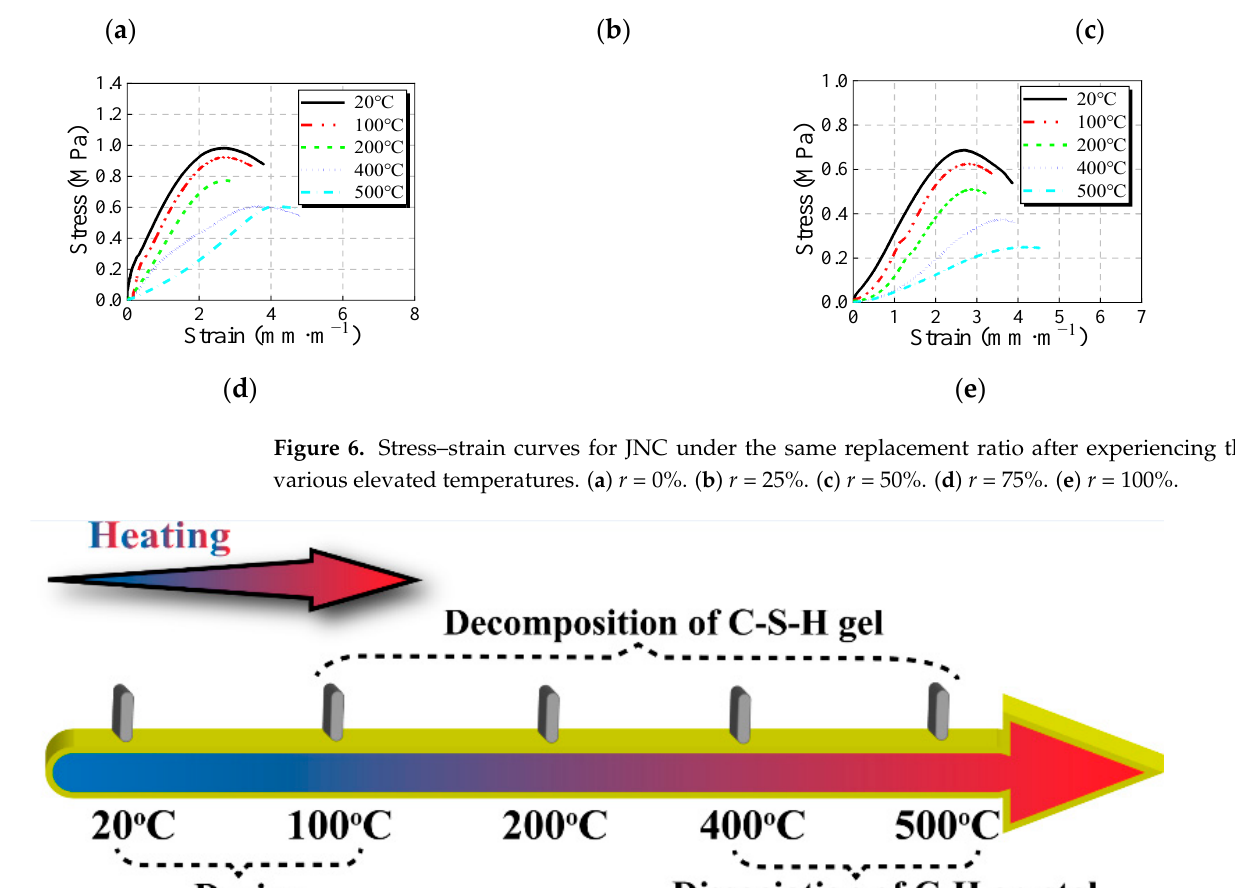
Figure 7. Effect of the elevated temperature on concrete.